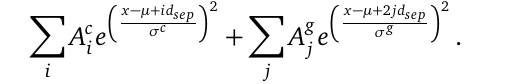
Figure 2: (top) Images taken with pulse U teraction strength and (bottom) the corresponding fitting result. Circles show the experiment data. Red and yellow solid lines shows the fitting result of the momen- tum peaks and background